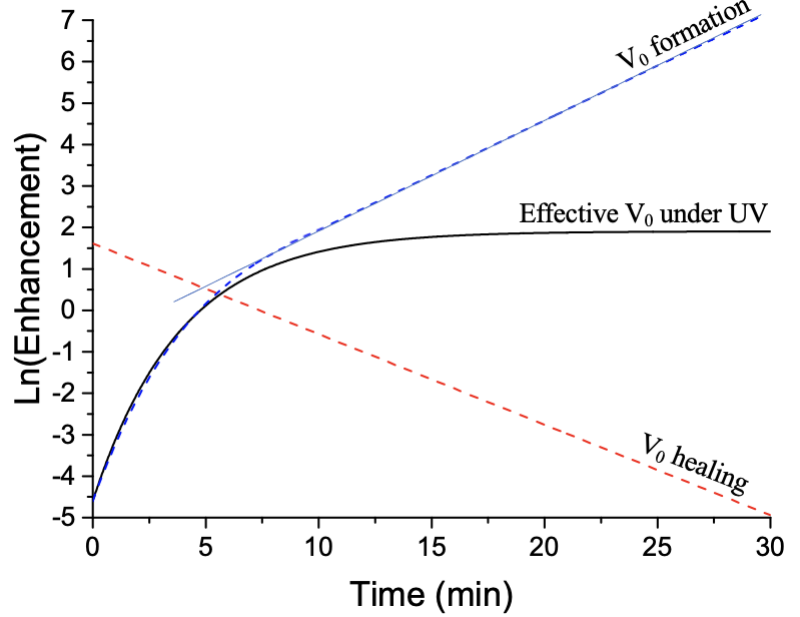
Figure 3. Logarithm of enhancement ( G PIERS − P ) owing to oxygen vacancies as a function of time. The red dashed line is obtained from the blue curve V 0 ( eff ) of Figure 2d, corresponding only to the V 0 healing and calculated by Equation (1). The black curve is obtained from the blue curve V 0 ( eff ) of Figure 2b, corresponding to the effective number of oxygen vacancies resulting from the difference between the formed and healed numbers of V 0 . The blue dashed curve is obtained through the deconvolution of curves of effective V 0 (under UV) and V 0 healing by using Equation (2). The values of each rate (formation and healing) correspond to the slope of the linear region of corresponding curves reported in Table